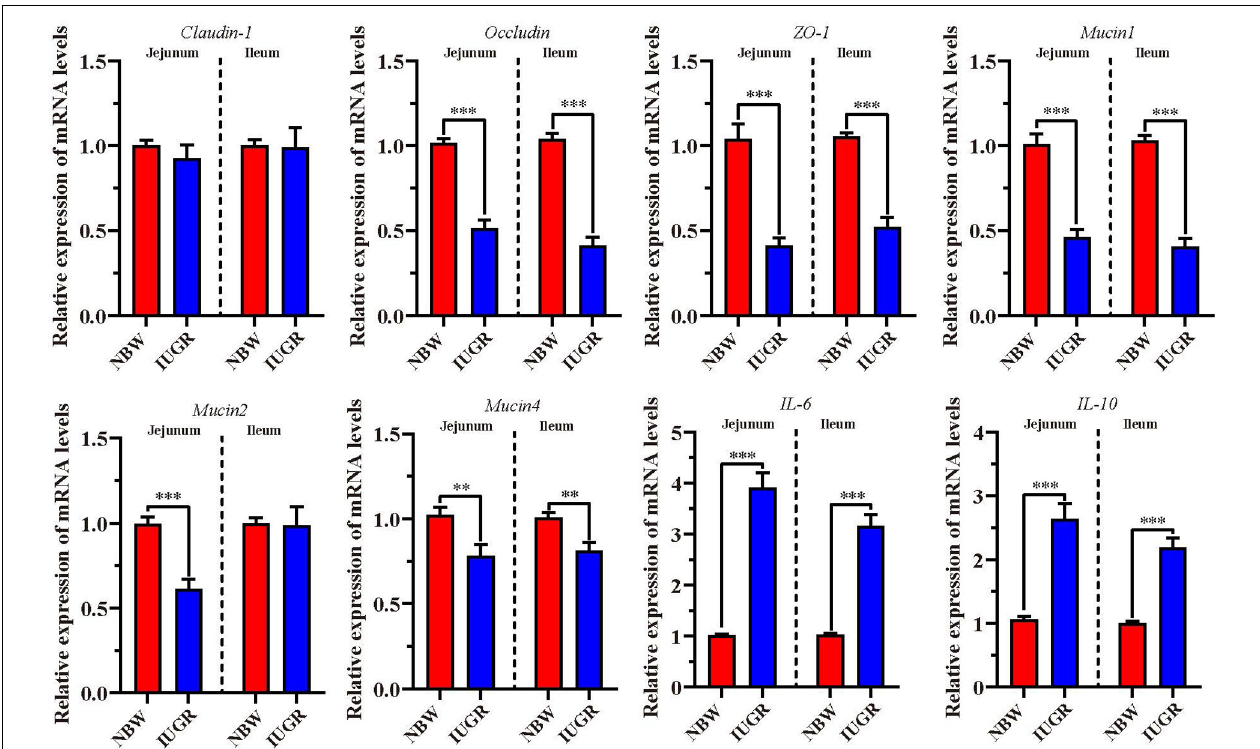
FIGURE 7 | Analysis of genes involved in intestinal barrier and proinflammatory cytokines. Data are shown as mean ± SEM. ∗∗ P < 0.01, ∗∗∗ P < 0.001. n = 9 per group. NBW, normal body weight; IUGR, intrauterine growth